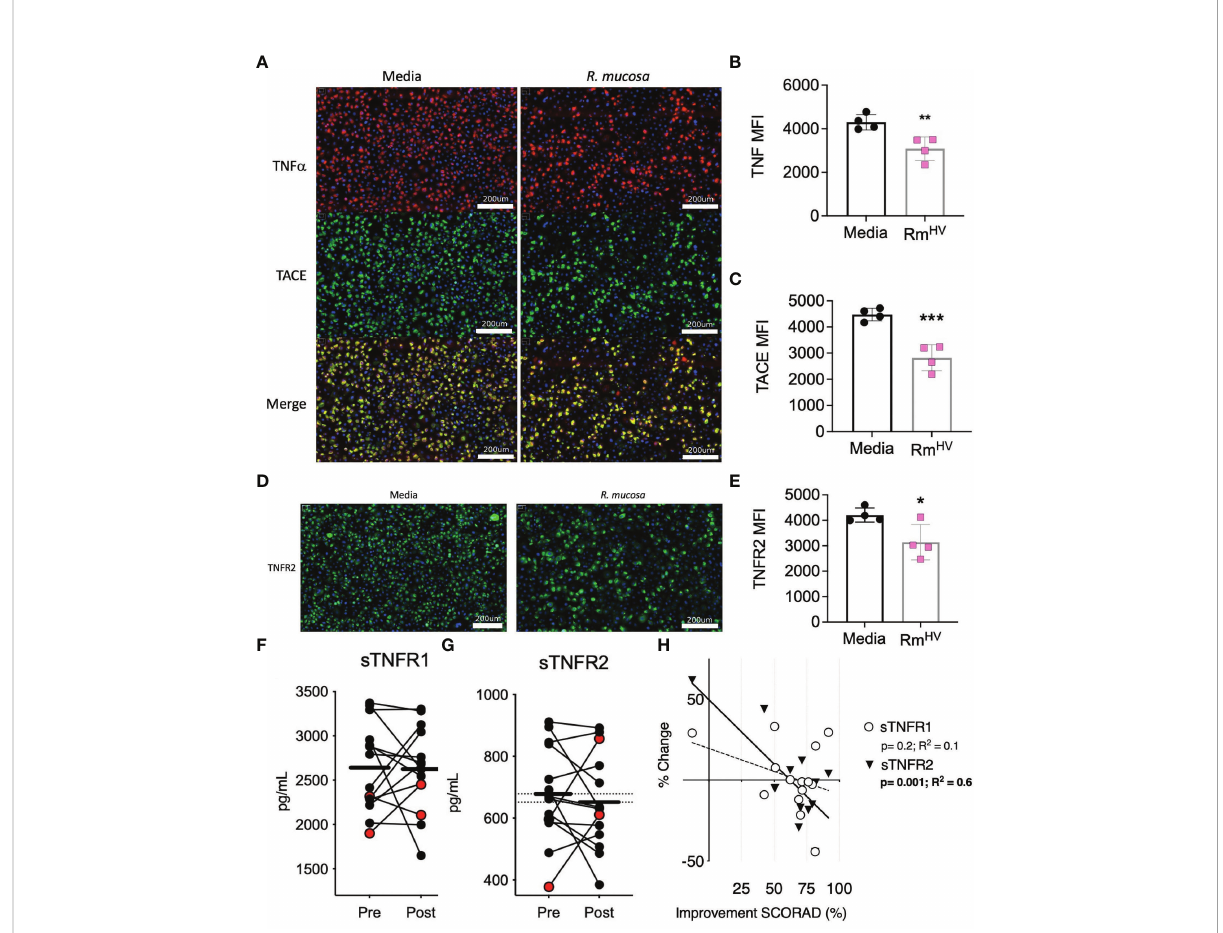
FIGURE 1 R. mucosa alters surface TNF-related marks in human keratinocyte cultures and patients with AD. (A) Representative images for immuno fl uorescent staining of tumor necrosis factor alpha (TNF a ; red), TNF a converting enzyme (TACE; green) and both (merge; yellow) for human primary keratinocytes stimulated with R. mucosa from healthy volunteers or media alone. White lines represent scale of 200 micrometers. (B, C) Quanti fi cation of signal for indicated marker in replicate wells. (D, E) Representative image (D) and quanti fi cation in replicate wells (E) for immuno fl uorescent staining of tumor necrosis factor receptor 2 (TNFR2). White lines (D) represent scale of 200 micrometers. (F – H) 14 pediatric patients with atopic dermatitis (AD) were treated with topical R. mucosa for a total offour months. (F, G) Levels of soluble tumor necrosis factor receptor 1 (sTNFR1) and sTNFR2 in the serum at enrollment (Pre) or after 16 weeks of active treatment (Post) are shown. Red dots indicate the two patients that did not achieve at least a 50% improvement in symptoms during treatment. (H) Percent change in sTNFR1 and sTNFR2 levels are contrasted against improvement in SCORing AD are shown along with a simple linear regression line. Data represent three independent experiments and are displayed as mean ± SEM. ***p<0.001, **p<0.01, *p<0.05 as determined by Student T